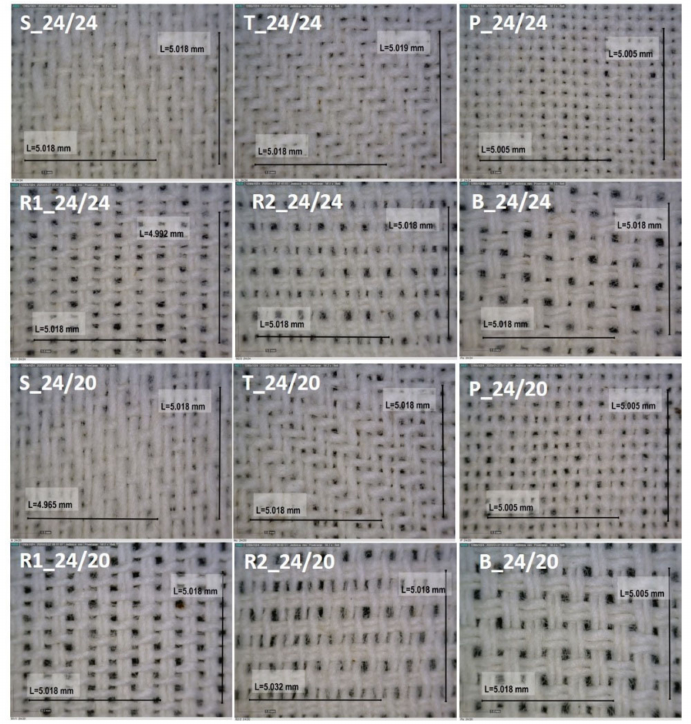
Figure 3. Microscopic image of the surface of fabrics and pores for each weave pattern and both thread densities, Magnification: 60 ×